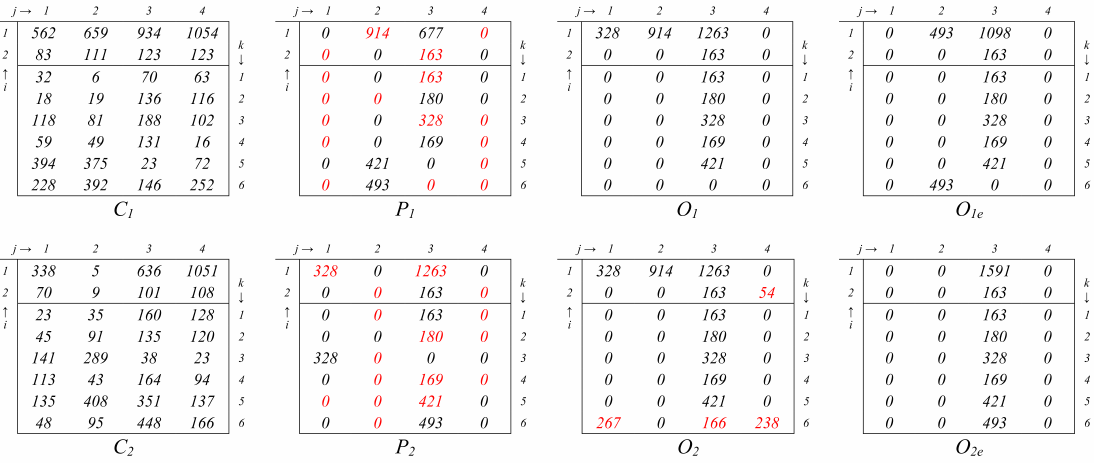
Figure 8. The genes of the chromosomes involved in the mutation and crossover